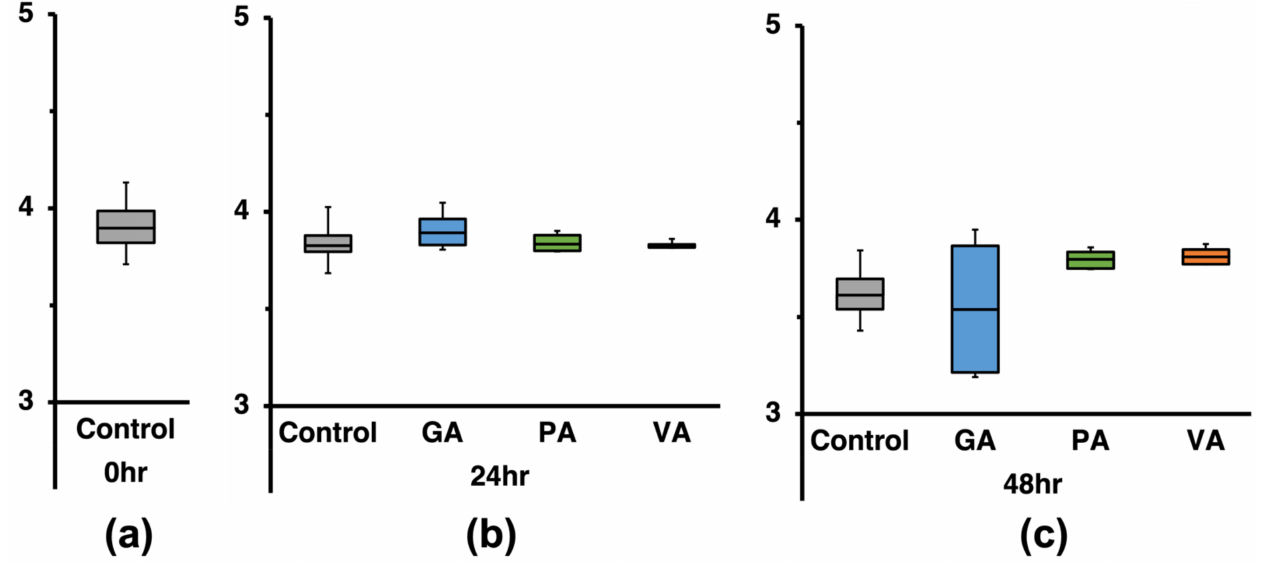
Figure 5. Alpha diversity analysis at the species level using the Shannon Index from 16S-rRNA gene sequencing data at 0 h ( a ), 24 h ( b ), and 48 h ( c ) for determining diversity for an untreated control and groups individually treated with either gallic acid (GA), protocatechuic acid (PA) and vanillic acid (VA).